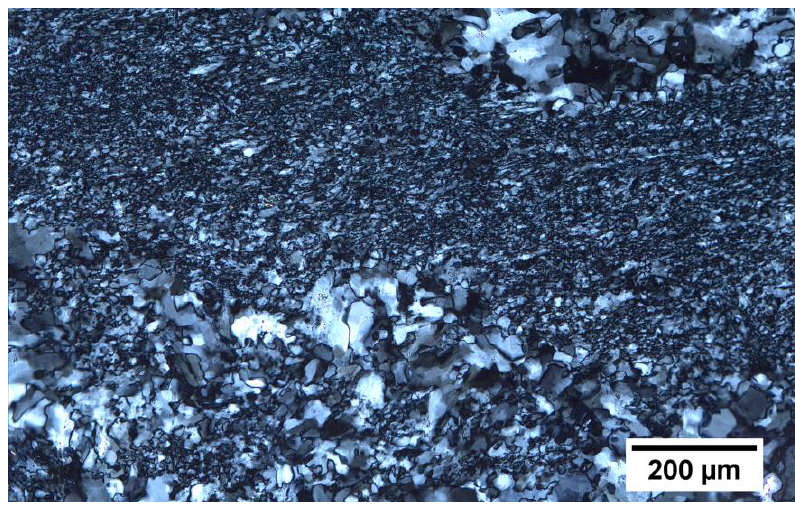
Figure 2. Microscopic image of the microstructure of a thin section specimen of the gypsum rock used in the experiments (recorded with cross-polarization).